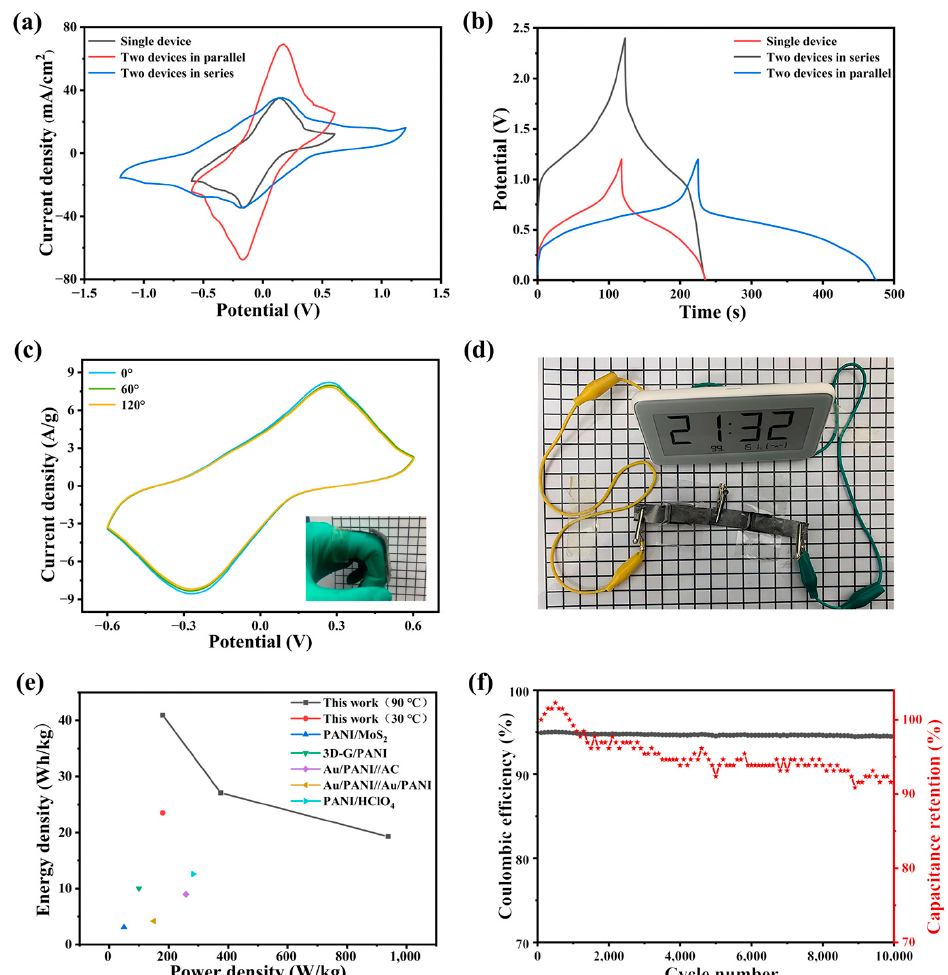
Figure 6. ( a ) CV curves of a single PAIMSC and two PAIMSCs in parallel or in series state; ( b ) GCD curves; ( c ) bending experiment of the PAIMSC at 100 mV/s; ( d ) physical connection diagram; ( e ) Ragone diagram of energy and power density comparison of PANI-based supercapacitors; ( f ) long- term cycling curve of PAIMSC.